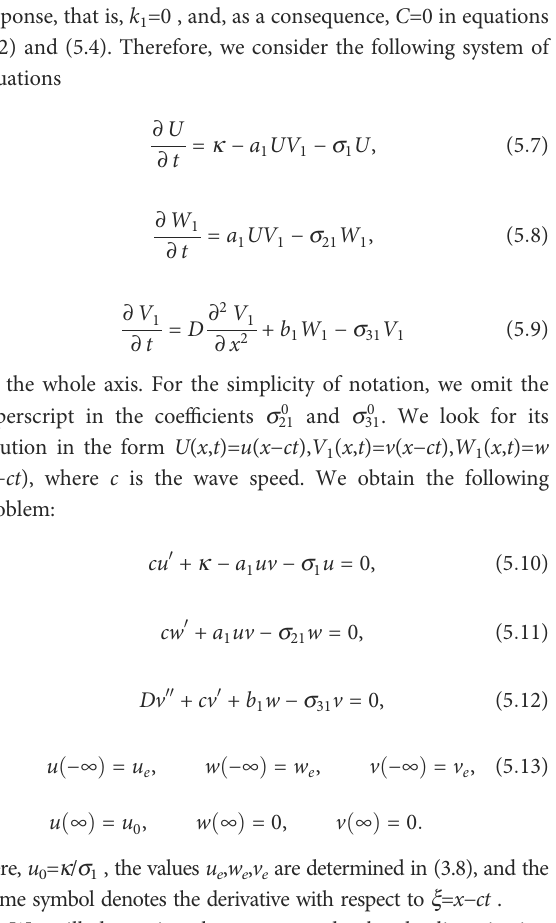
FIGURE 6 Schematic representation of the model with two viruses competing for uninfected cells. There are two types of infected cells corresponding to the virus type. Both types of viruses and infected cells are eliminated by the immune